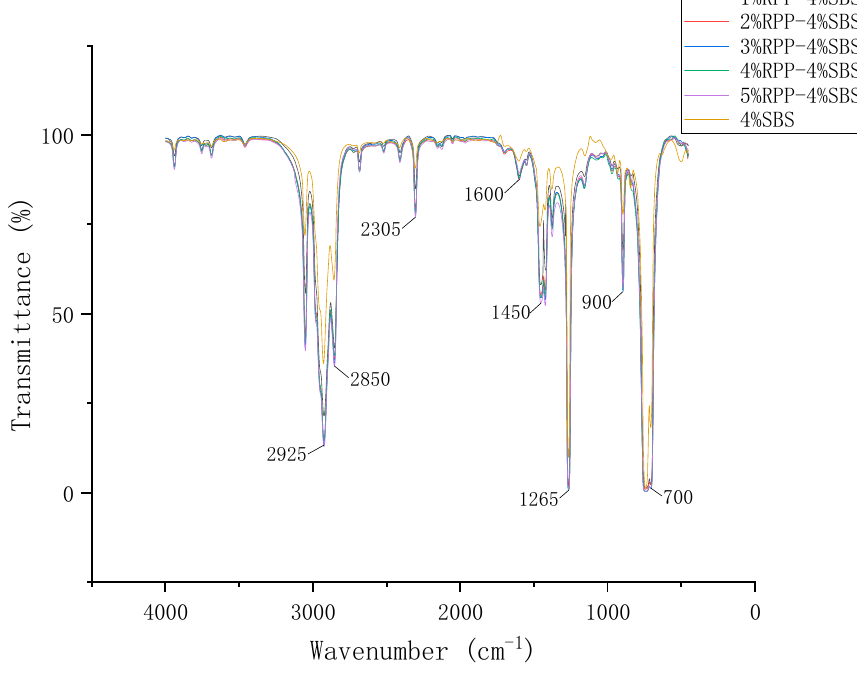
Figure 17. Infrared spectra of modified asphalt.